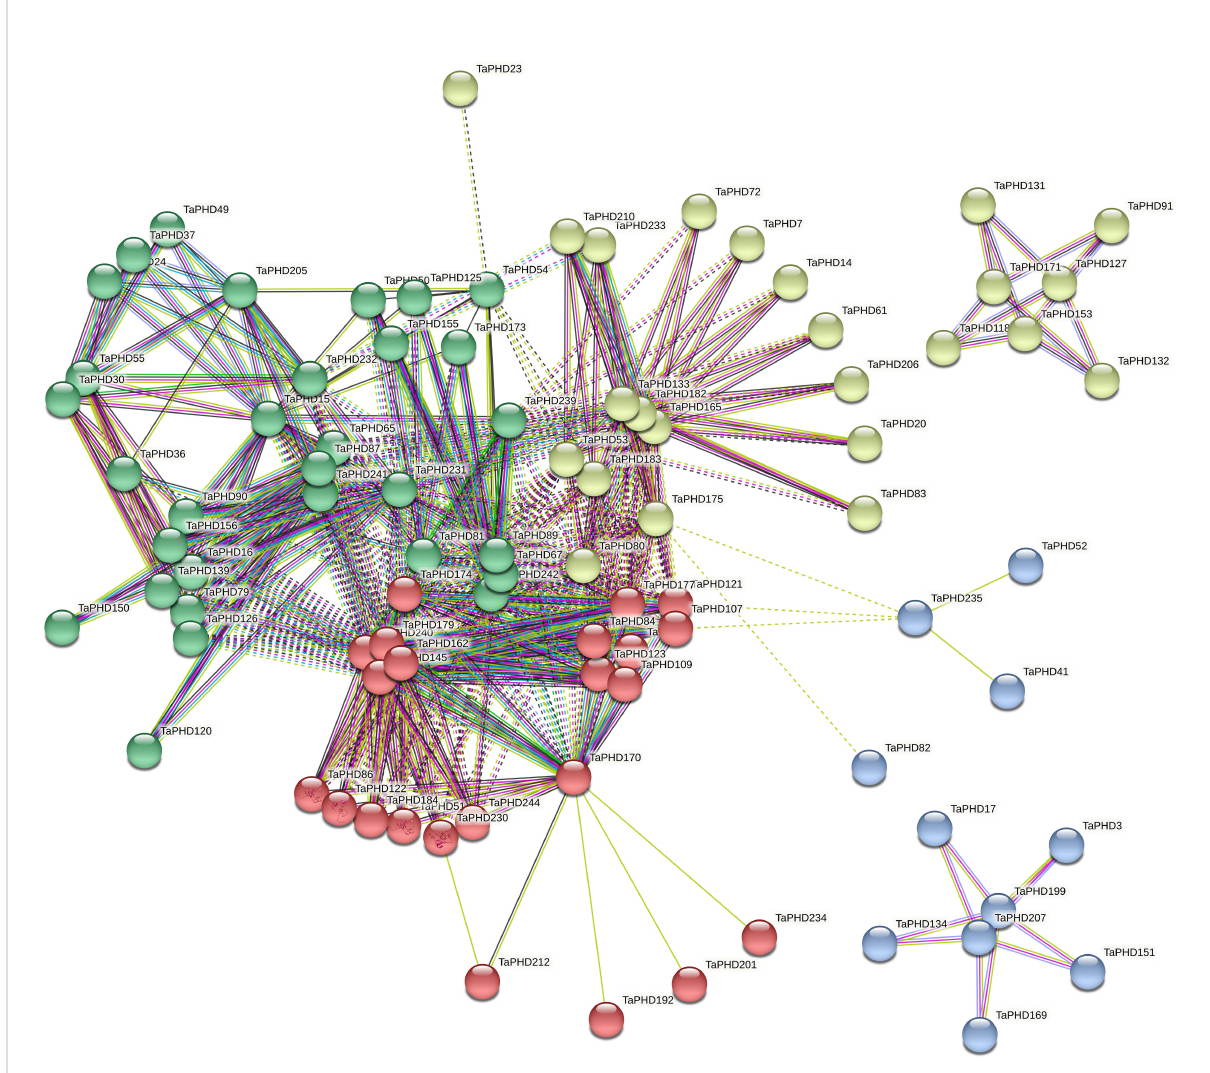
FIGURE 7 Predicted protein association networks analyses of TaPHD proteins. The four colors represent different interaction areas. The nodes represent the proteins, and the lines represent the protein-protein associations. Light blue and purple lines represent the known interactions from the curated database or experimentally determined interactions; green, red, and blue lines represent gene neighborhood, gene fusions, and gene co-occurrence, indicating that the proteins have the predicted interactions; yellow, black, and light blue lines represent textmining, co- expression, and protein homology,